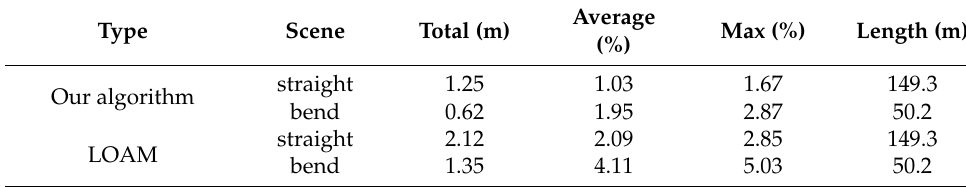
Figure 9. Mapping of actual scene. ( a ) Map of straight road. ( b ) Map of bent road. Table 1. Absolute and relative position error.